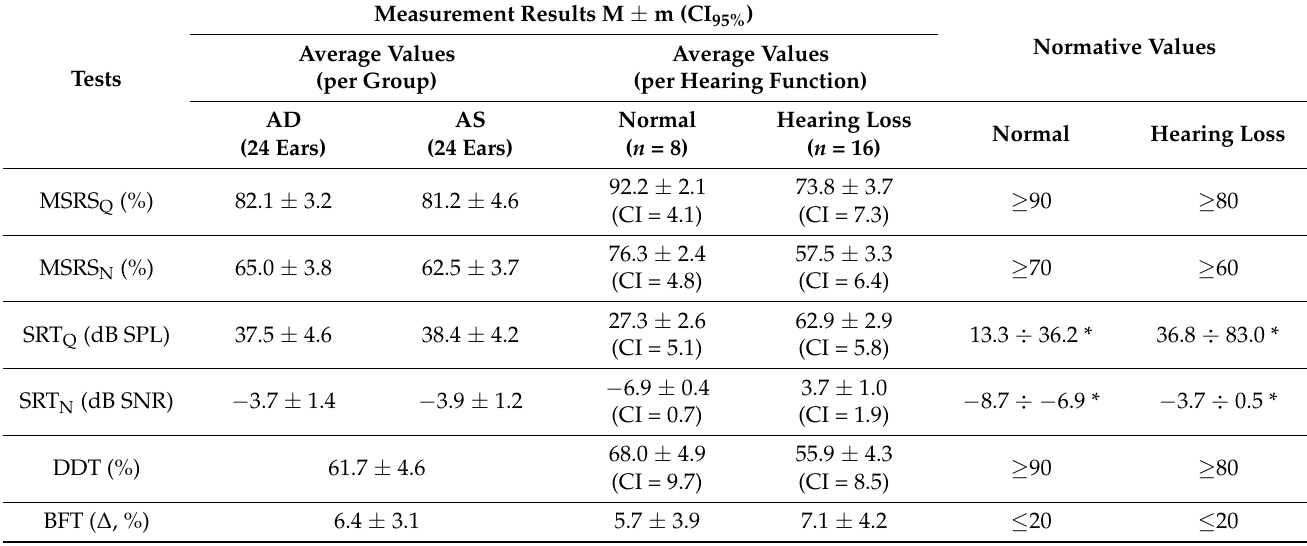
Table 2. Results of extended speech testing of patients after COVID ‐ 19 ( n = 24, 48 ears).